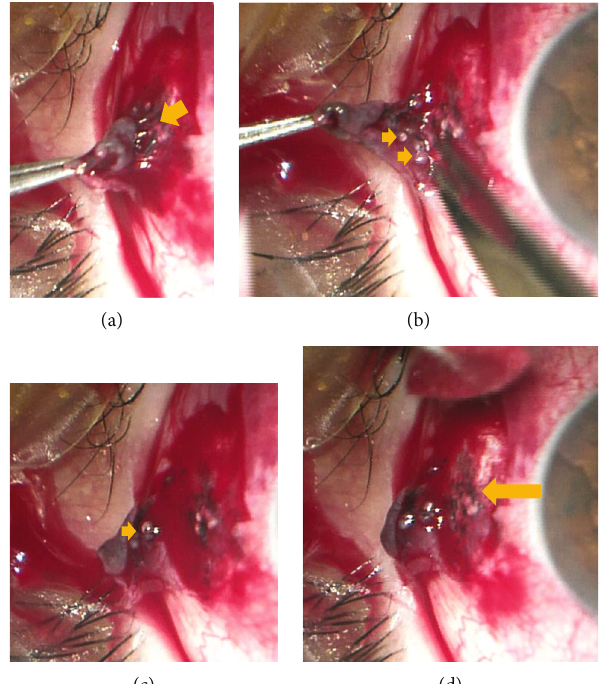
Figure 3: (a) Showing subconjunctival scarring (arrow), (b, c) subconjunctival silicone oil bubbles, and (d) dispersed pigmentation on the scleral surface .